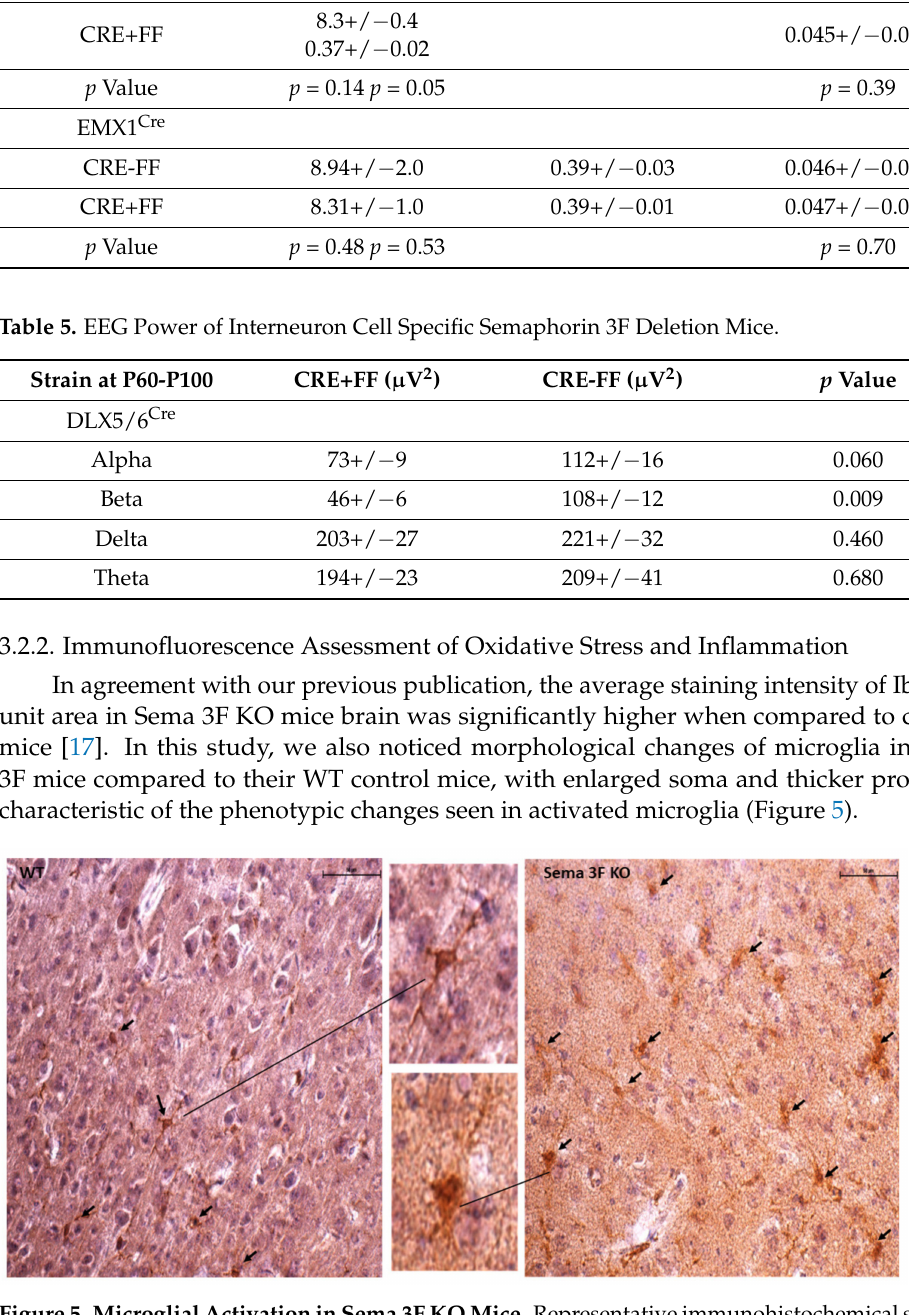
Figure 5. Microglial Activation in Sema 3F KO Mice . Representative immunohistochemical staining showed increased microglial activation in Sema 3F KO mice, i.e., an increased number of Iba-1 positive cells with enlarged soma and thicker processes (black arrows), compared to their wild type (WT) littermates; n =